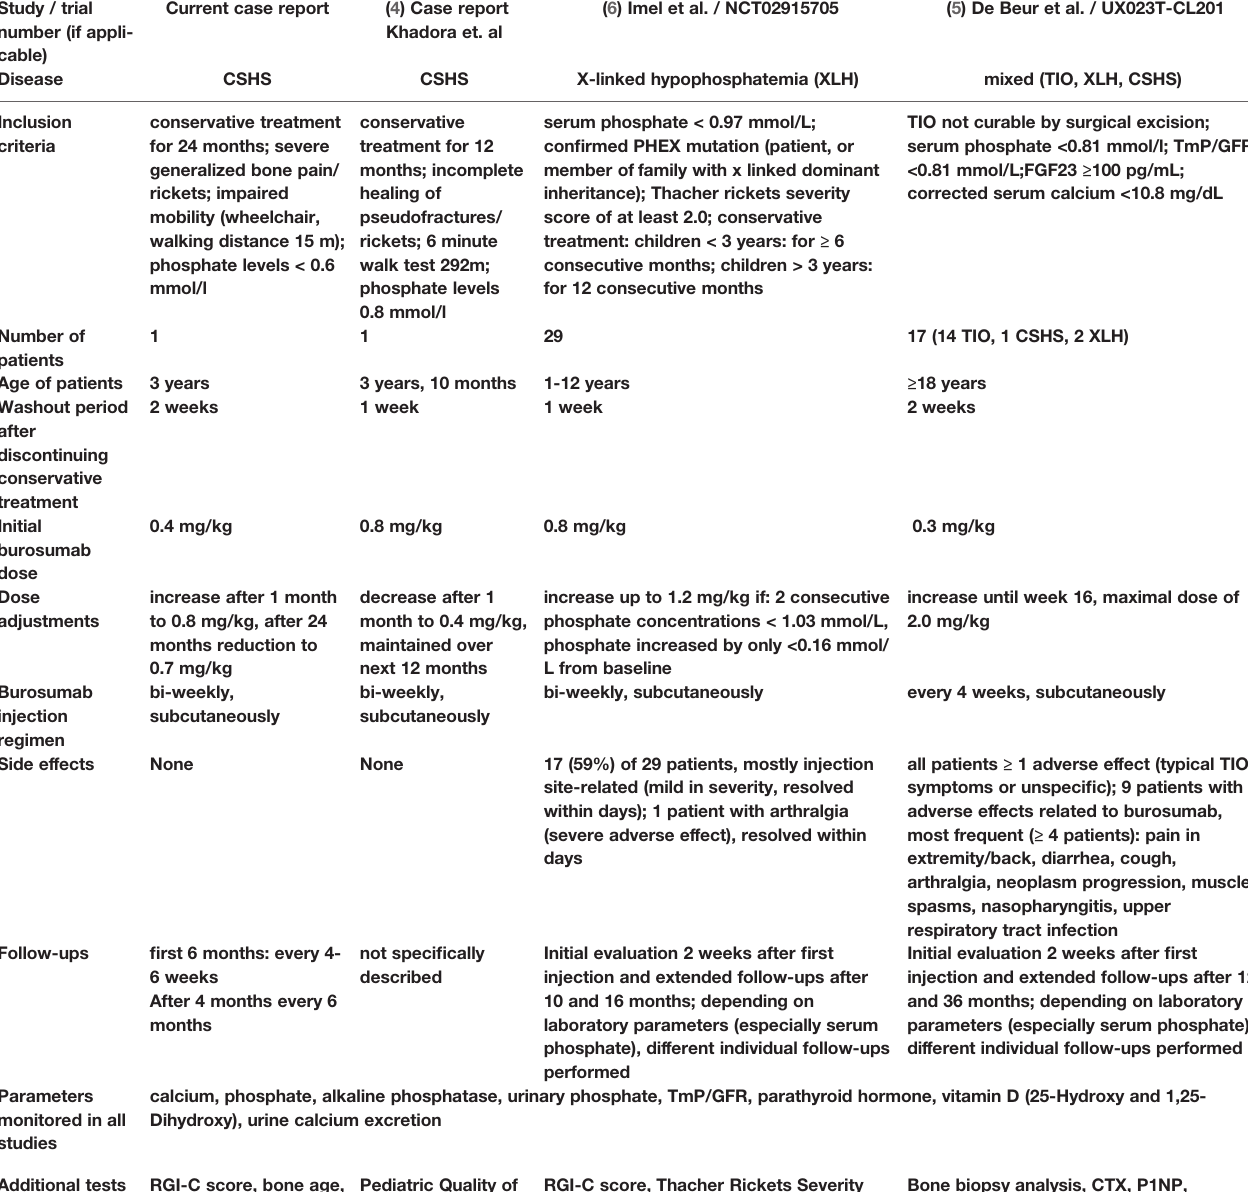
TABLE 1 | Comparison of burosumab treatment regimens, dose and follow-up across pediatric and adult patients with monogenic or paraneoplastic hypophosphatemia syndromes. Study / trial number (if appli-